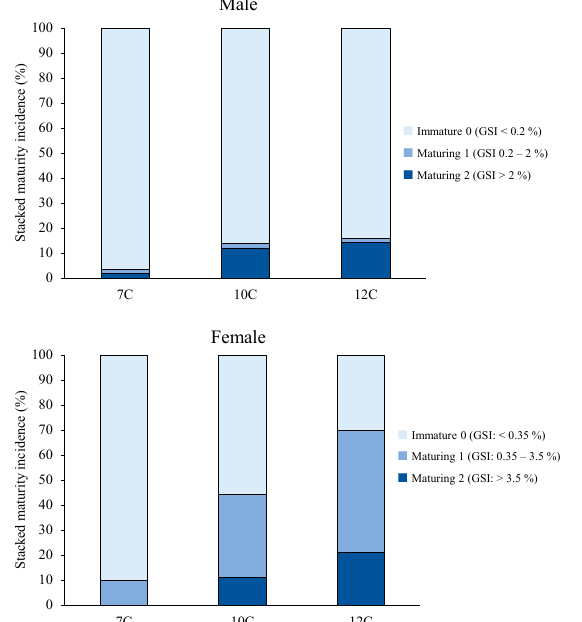
Figure 3. Harvest maturity incidence (%) in male and female Arctic charr reared at 7, 10, and 12 ◦ C during the juvenile stage. Mean GSI values within each maturation class are shown in Table 1. Overall, maturing males and females had higher W at day 234 than immature fish. However, at harvest on day 654, the size rank was reversed and the fish in immature stages had the highest W (Table 1). The effects of sexual maturation on growth can be observed in greater detail when the relative size differences of immature and maturing fish are compared retrospectively from tagging on day 234 until harvest. When compared with immature males, second-stage mature males in the 10C and 12C groups were gen- erally larger during the juvenile stage. However, the maturing males showed depressed growth as early as one year before harvest and weighed 63% and 54% less than the im- mature males in the 10C and 12C groups, respectively (Figure 4).